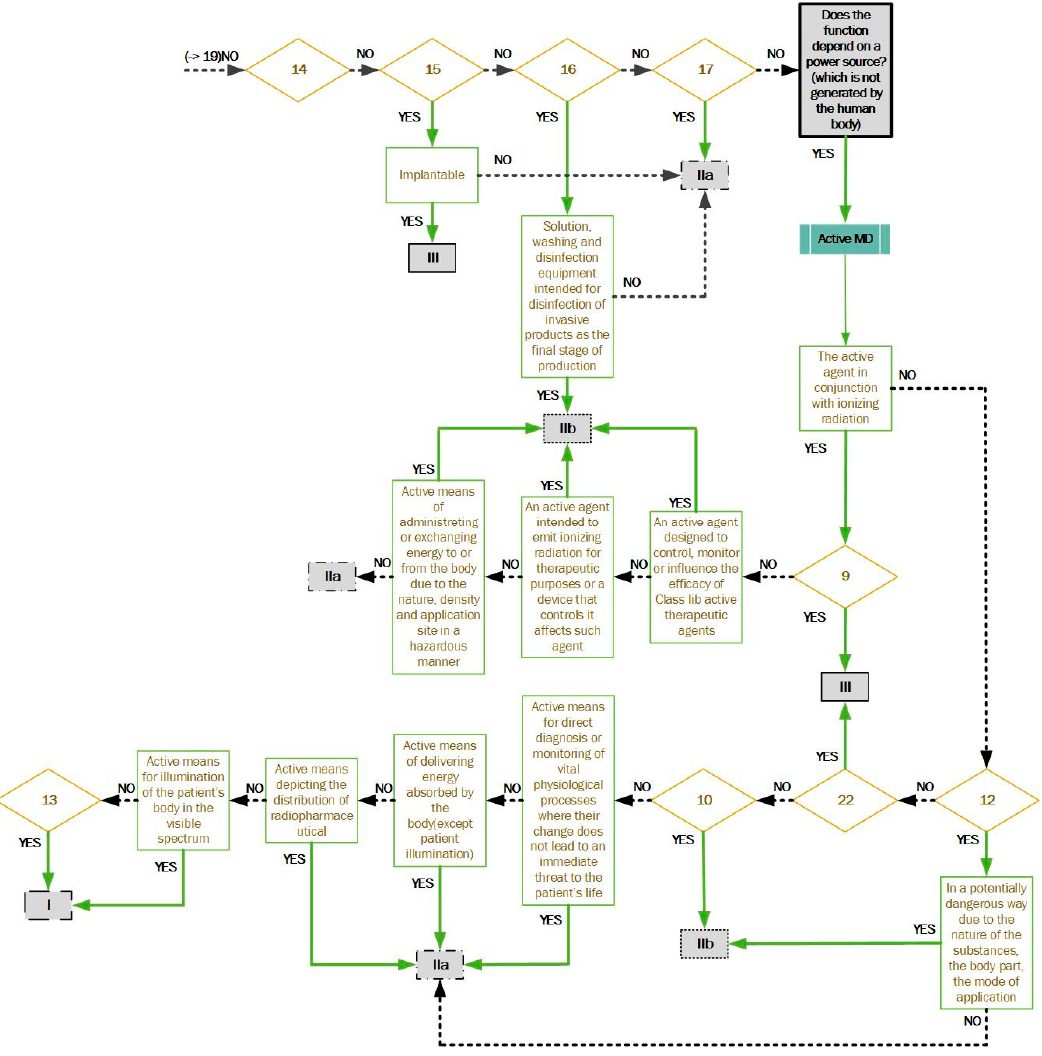
Figure 2. The second phase of the decision.